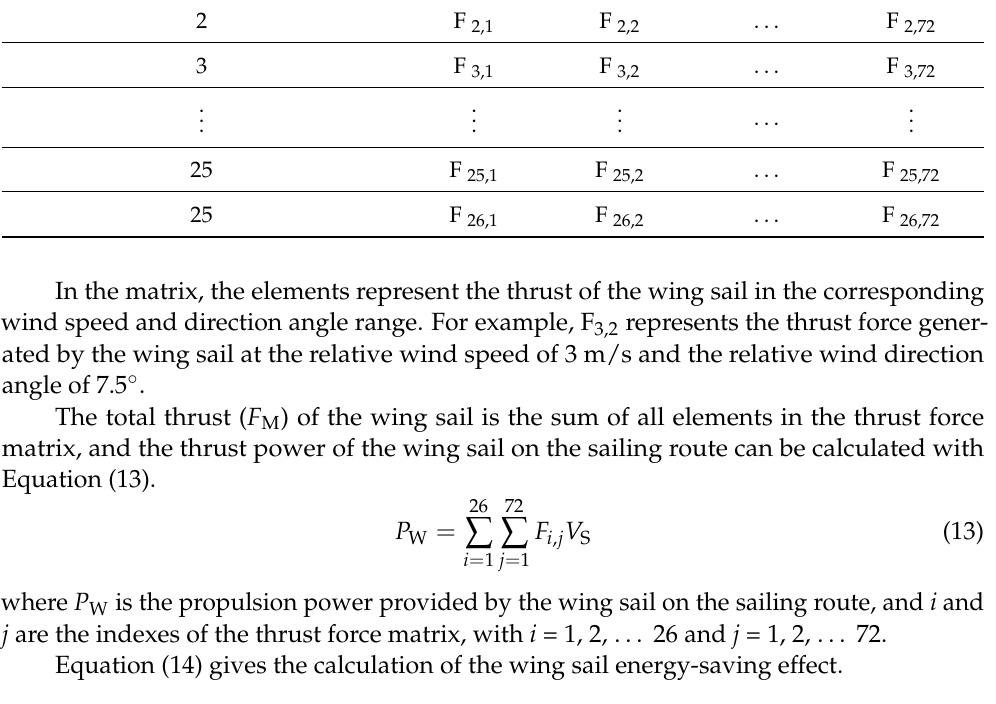
Table 2. Layout of the thrust force matrix of wing sails. Wind Angle ( ◦ Wind Speed (m/s)